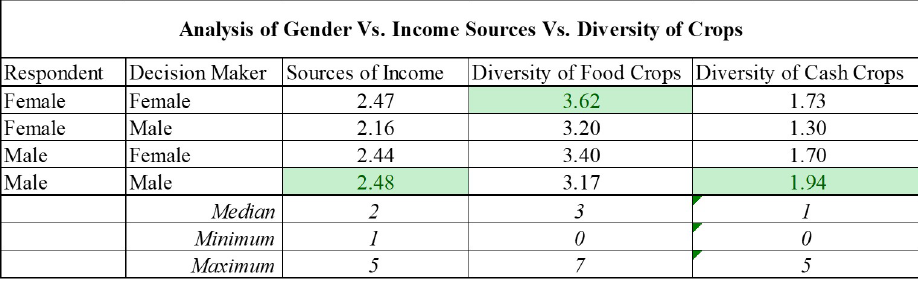
Figure 14. Relationship between gender, adaptation bias and